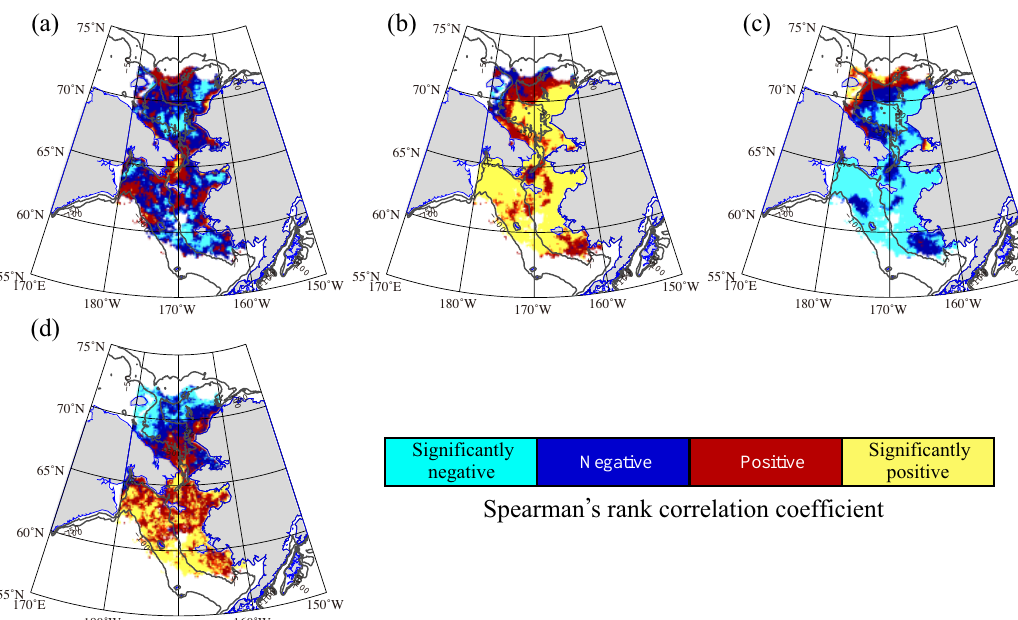
Figure 5. Spatial distributions of Spearman’s rank correlation ( ρ ) between (a) F L during MIZ period and TSR, (b) SST during MIZ period and TSR, (c) (cid:49) OHC during MIZ period and TSR, and (d) PAR during MIZ period and TSR. Yellow indicates a significantly positive ρ ( p <0.05); red, a positive ρ ( p >0.05); blue, a negative ρ ( p >0.05); and light blue, a significantly negative ρ ( p <0.05). The proportions of the coefficients are listed in Table 3. Contours indicate 50m and 100m bathymetry lines.